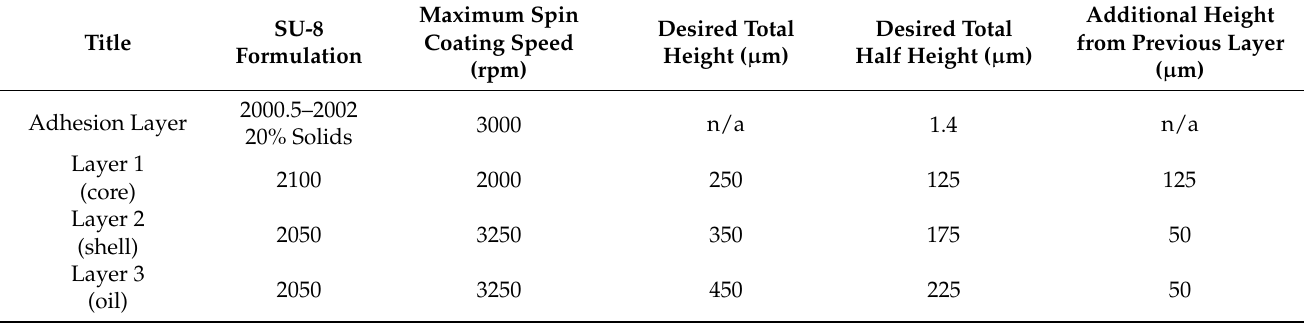
Table 1. Resist formulation, maximum spin coating speed, and desired channel height for device